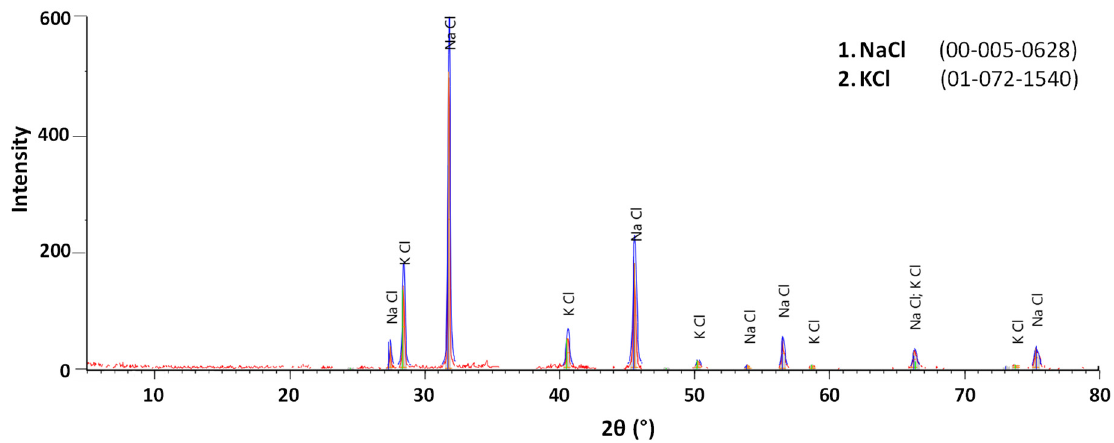
Figure 11. Mineralogical phases (XRD patterns) of crystallized salts after evaporation.